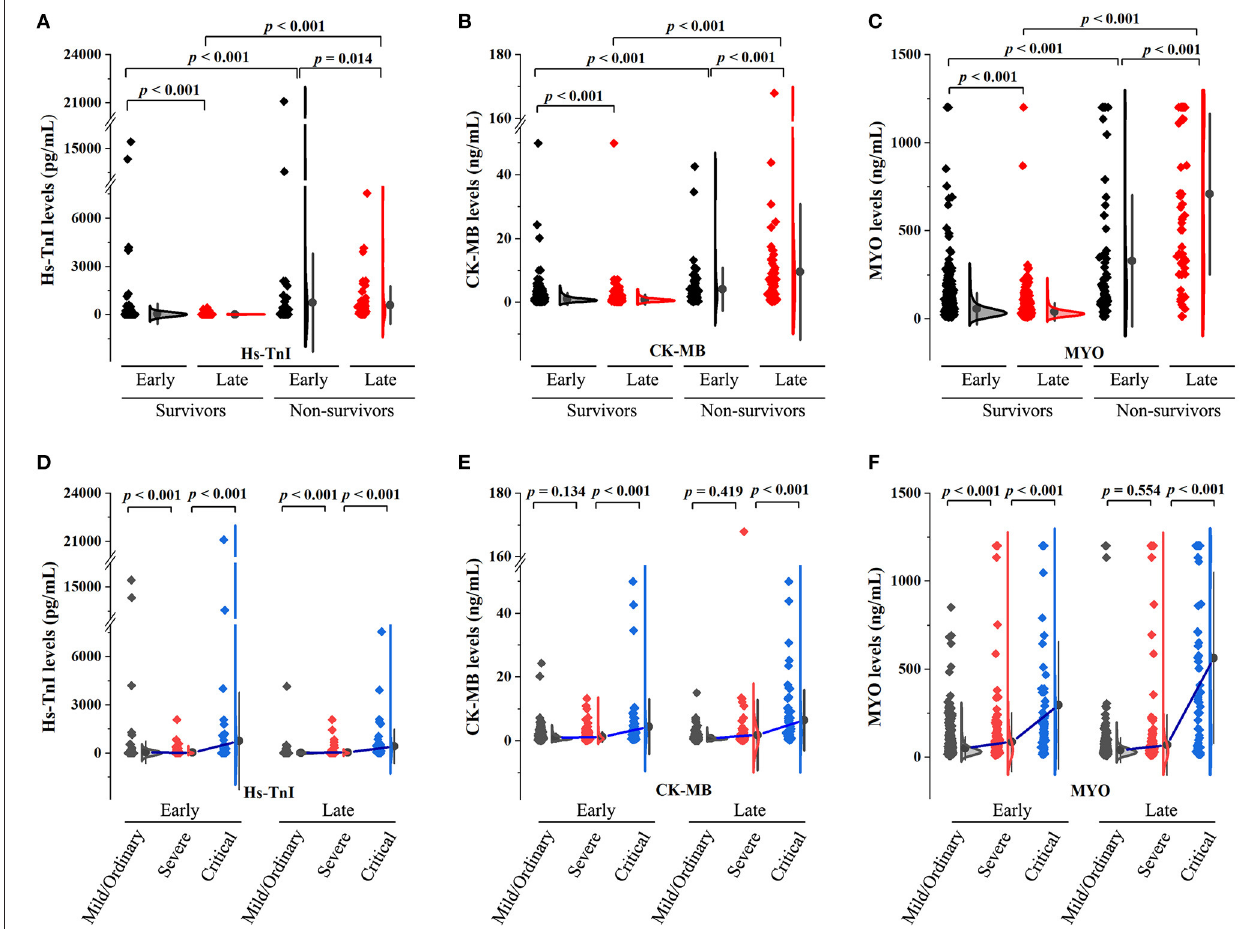
FIGURE 1 | Summary of myocardial biomarker levels in patients with COVID-19. (A–C) The early- and late-stage levels of myocardial biomarkers in patients stratified by mortality. (D–F) The early- and late-stage levels of myocardial biomarkers in patients stratified by clinical